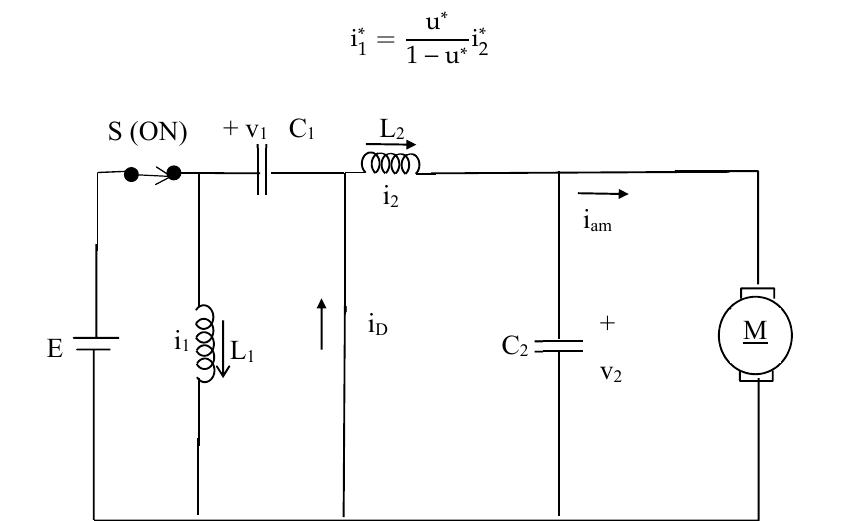
Figure 2. Converter status when the switch is on (field circuit of motor is omitted).